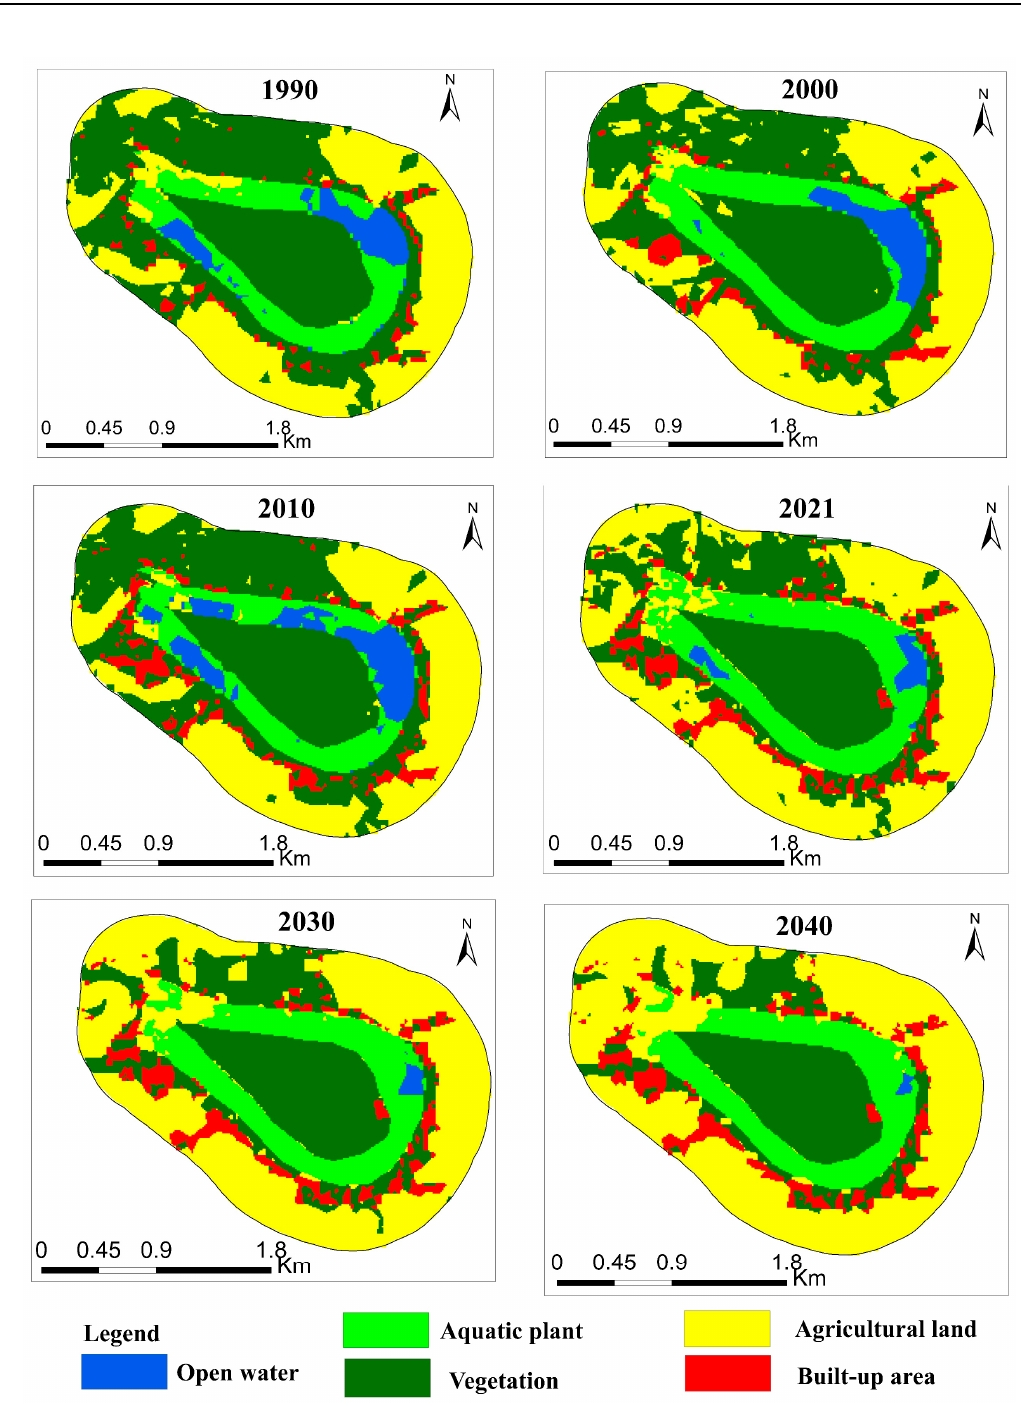
Figure 3. Land-use/land cover map of the study area for 1990, 2000, 2010, 2021, 2030, and 2040.